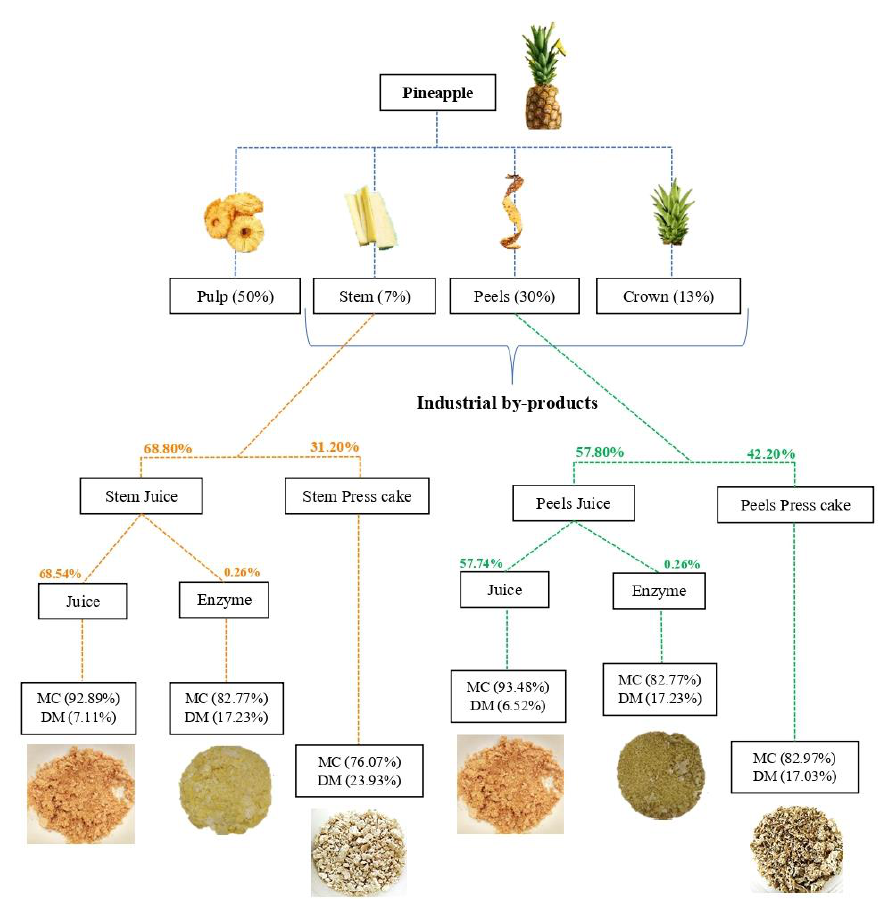
Figure 1. Flow chart of the biomass balance of pineapple by-products (stems and peels) according to an integral valorization towards six functional ingredients. Abbreviations: DM (dry matter) and MC (moisture content).